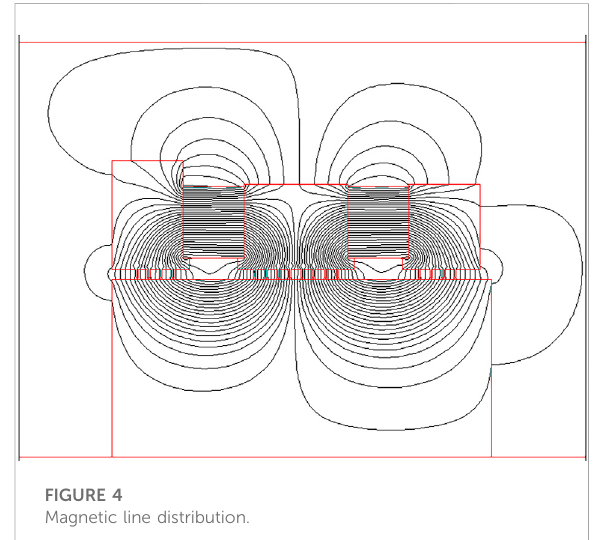
FIGURE 4 Magnetic line distribution.